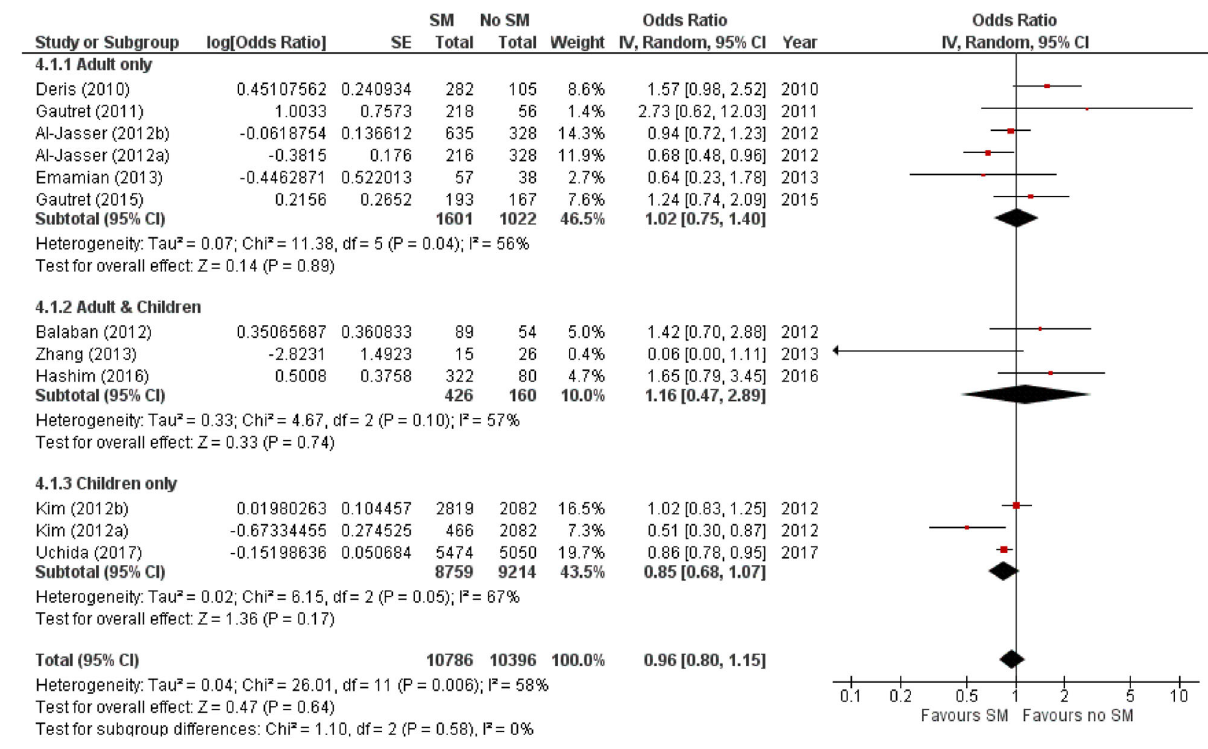
FIGURE 2 | Pooled odds ratio for ARI incidence when surgical masks were worn, compared with not wearing surgical masks, in observational studies (n = 10 studies) estimated with the generic inverse method and a random-effects model. SM, surgical face mask; No SM, no surgical face mask; OR, odds ratio.